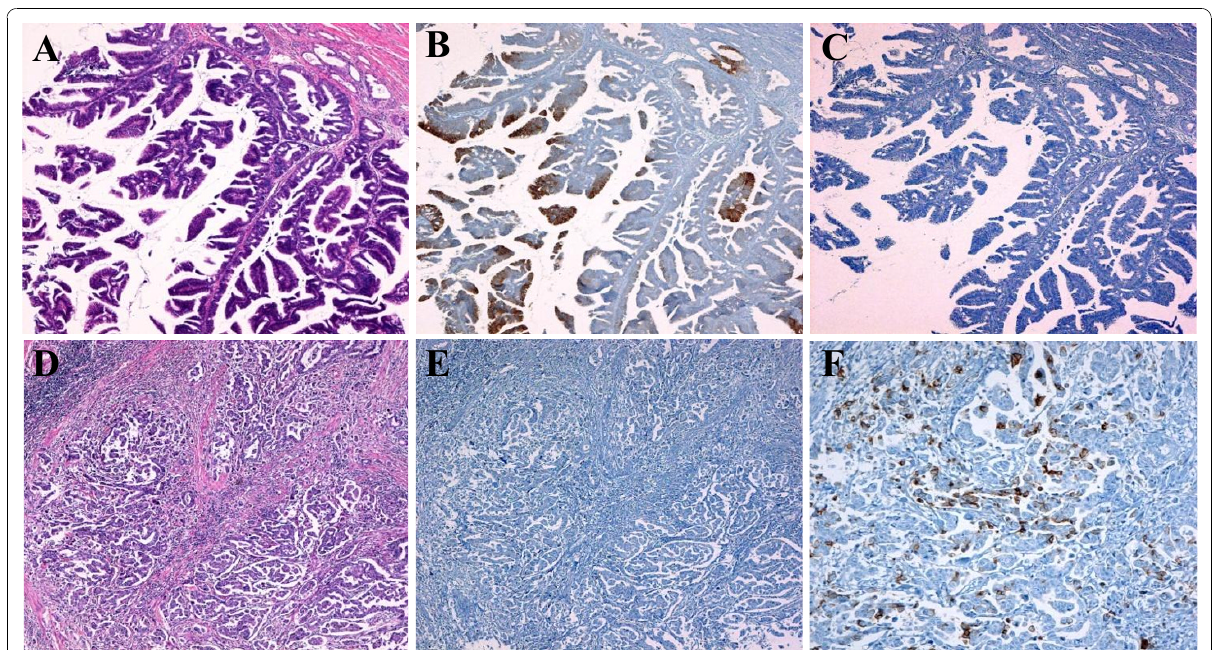
Figure 1 Expression of cytokeratin and apomucin for histological classification . Intestinal-type carcinomas are composed of well-formed tubular to elongated glands and complex cribriform areas indistinguishable from colorectal adenocarcinomas (A), and they are immunohistochemically stained by the CK20 antibody (B) but show no reaction to the MUC1 antibody (C). Pancreatobiliary-type carcinomas mostly consist of simple or branching glands surrounded by strikingly desmoplastic stroma (D) negative for CK20 (E) and positive for MUC1 antibody (F) (A, D: hematoxylin and eosin stain, ×20; B, C, E: ×20;F ×50).